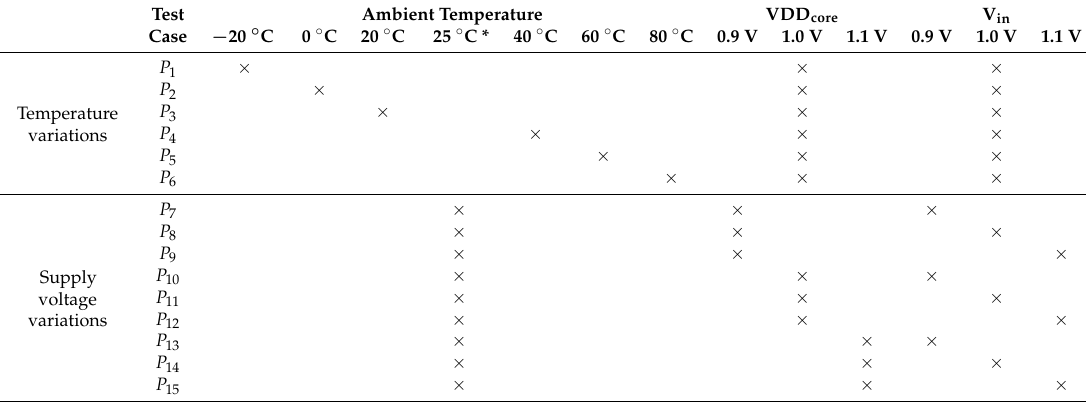
Table 1. Test cases for PUF experiments (test cases marked with × denote the configured testing setup, * Ambient room temperature).